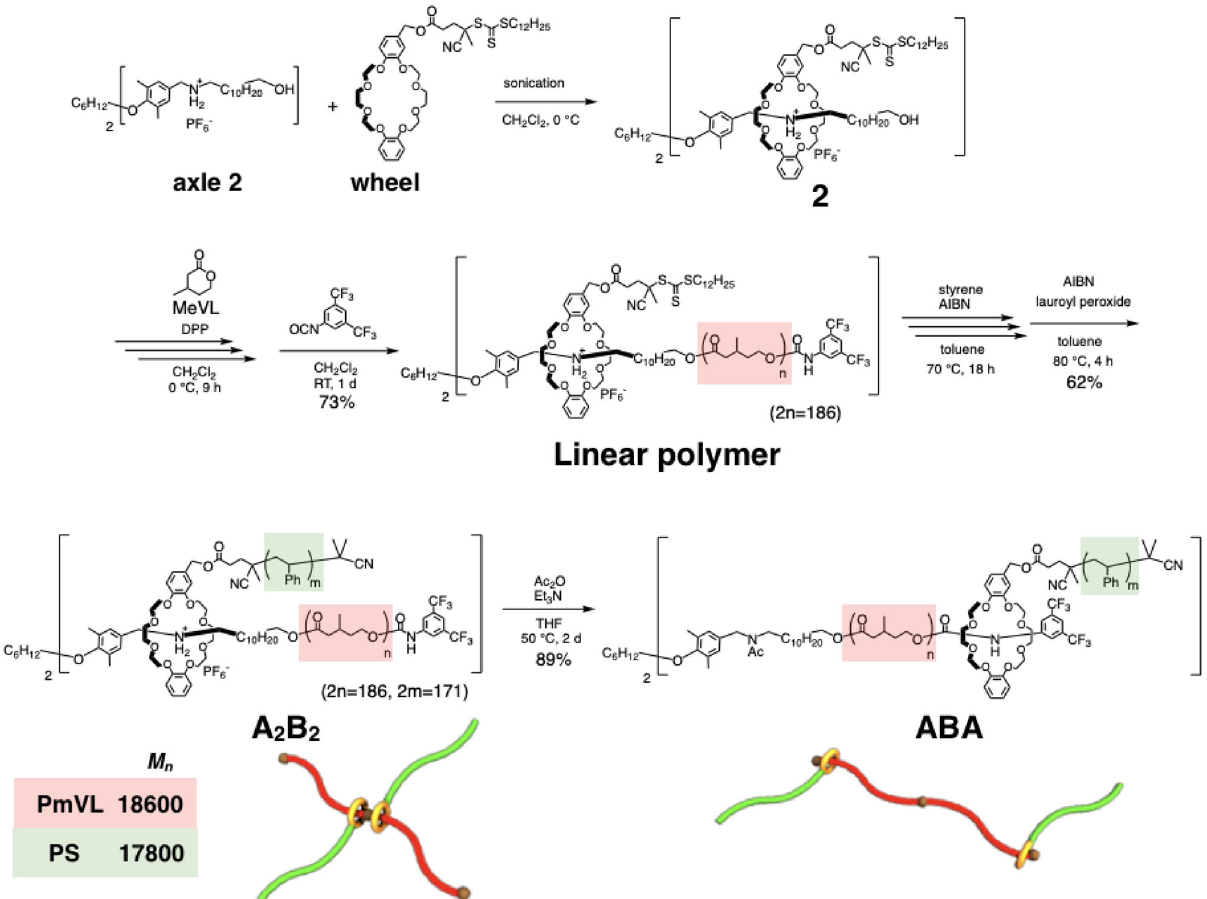
Fig. 5 Synthetic scheme of a rotaxane-linked A 2 B 2 polymer and its transformation into an ABA topology. Living ring-opening polymerization of MeVL using a pseudo-[3]rotaxane initiator ( 2 ), reversible addition − fragmentation chain transfer (RAFT) polymerization of styrene onto the crown ether, and topology transformation via acetylation of the sec -ammonium moiety at the center of the polymer